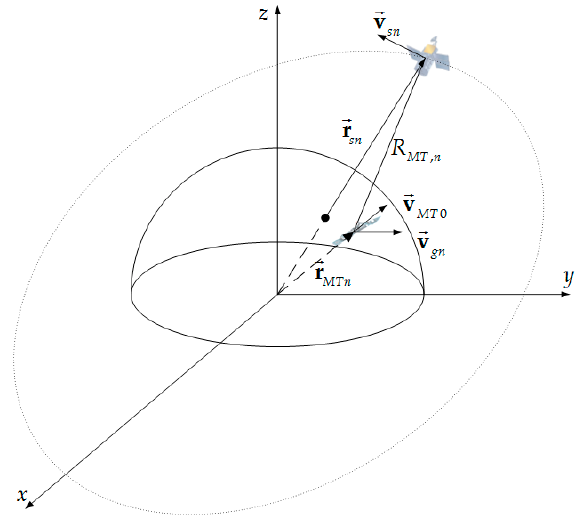
Figure 1. Geometry of moving ship targets and geosynchronous synthetic aperture radar (GEO SAR).